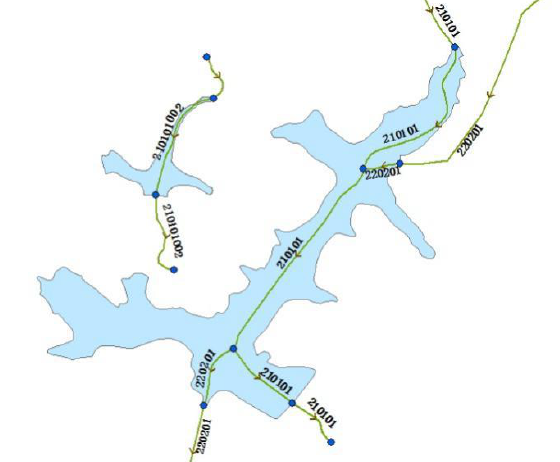
Figure 3. Schematic of results of attribute